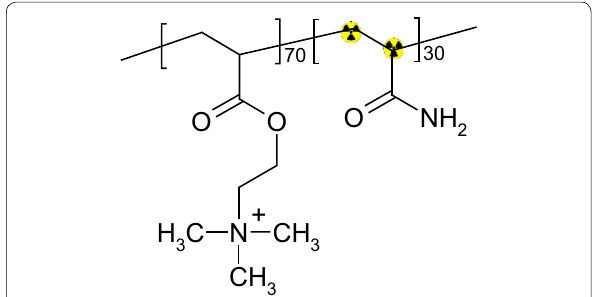
Fig. 1 Chemical structure of 14 C-PAM used in the